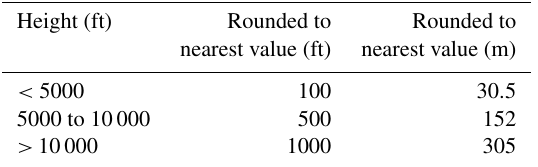
Table 2. The ceilometer ˆ z base retrievals are rounded to different val- ues depending on their height window according to ASOS User Guide (National Oceanic and Atmospheric Administration, De- partment of Defense, Federal Aviation Administration, and United States Navy, 1998). The values are originally given in feet and are converted to meters here. Rounded